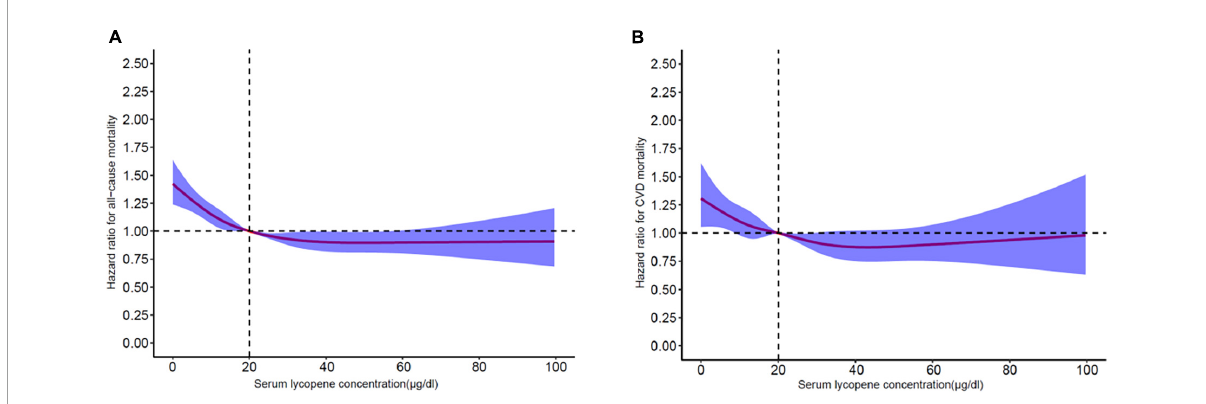
FIGURE2 (A) Restricted cubic spline analyses between serum lycopene concentrations and all-cause mortality. (B) Restricted cubic spline analyses between serum lycopene concentrations and cardiovascular-cause mortality.